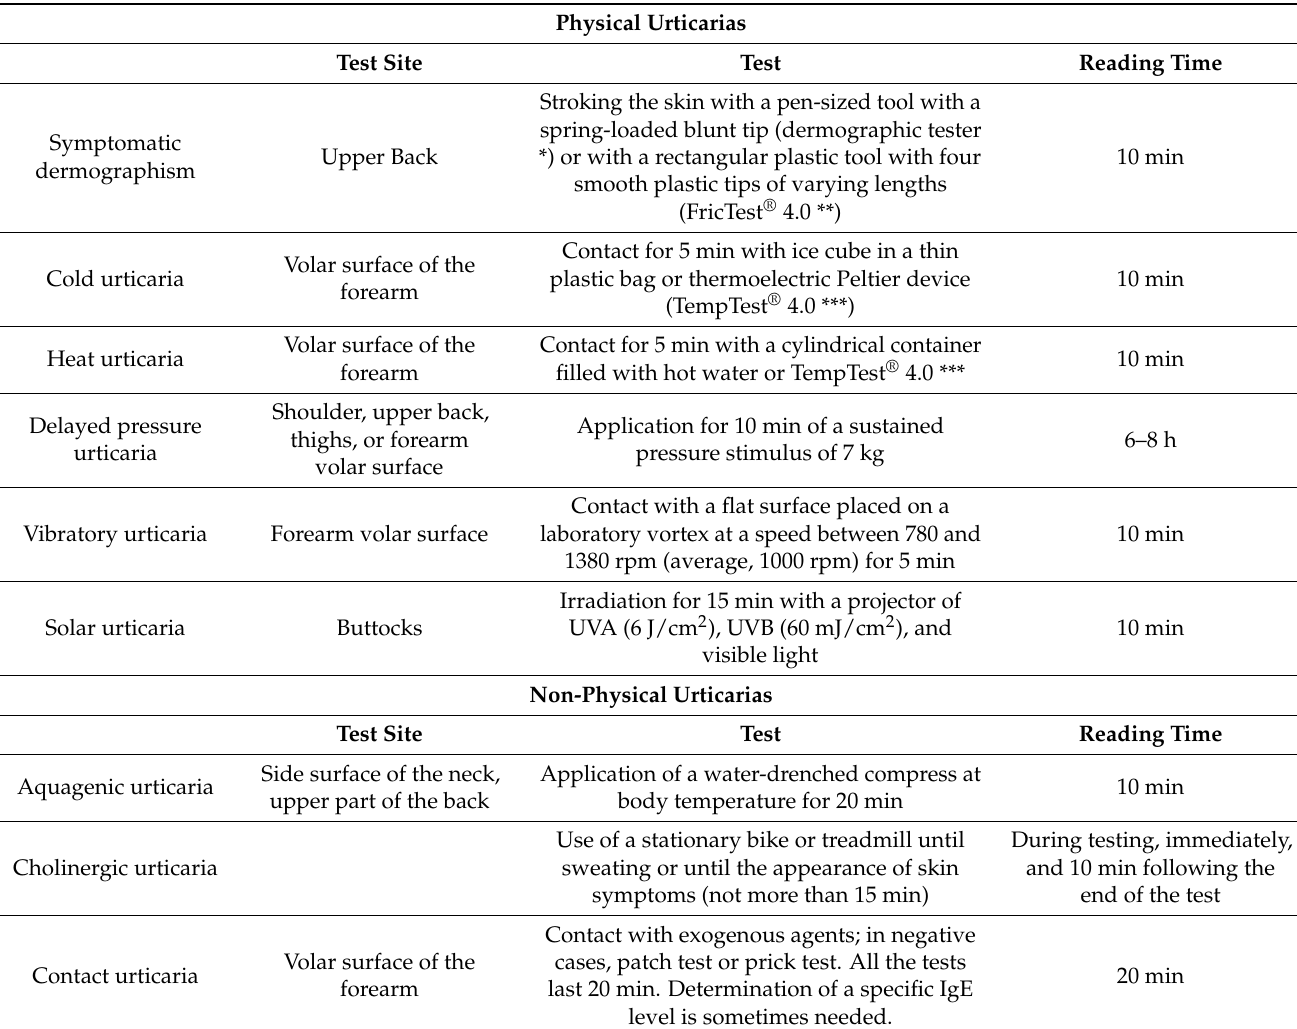
Table 2. Main challenge tests used for the diagnosis of